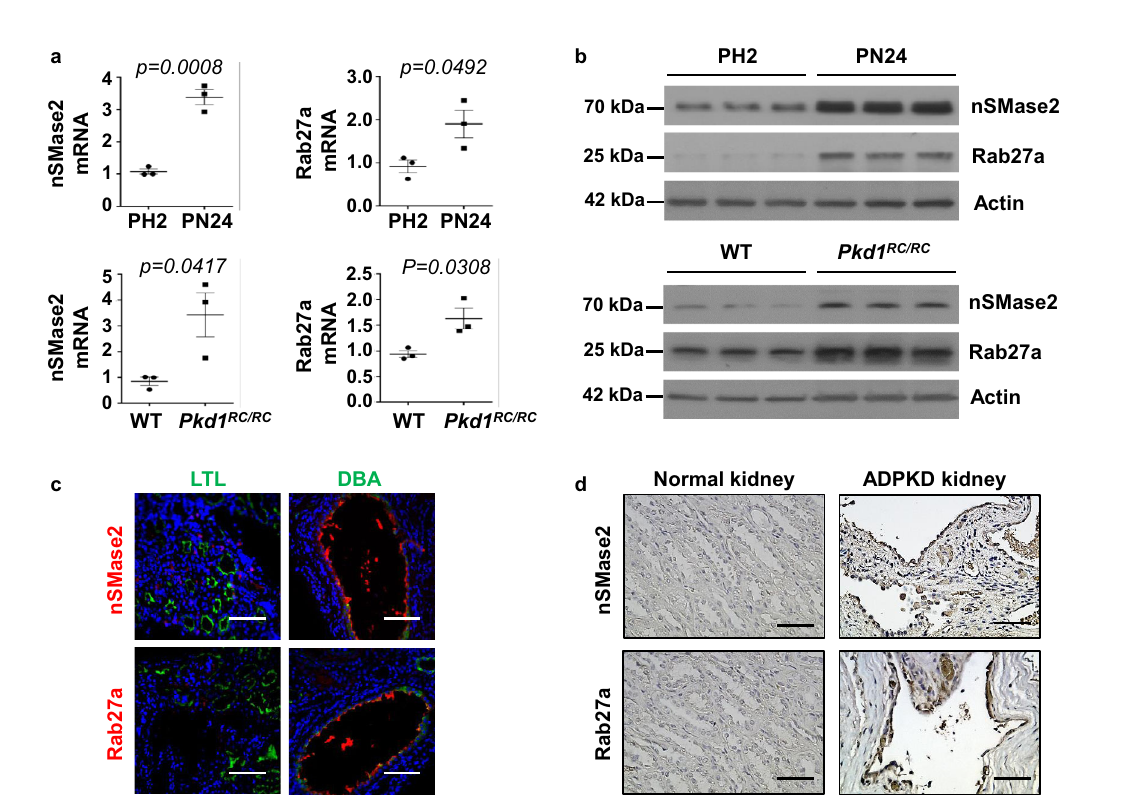
Fig. 7 The expression of exosome biogenesis/release-associated genes was upregulated in Pkd1 mutant renal epithelial cells and tissues. a qRT-PCR analysis of the expression of nSMase2 and Rab27a mRNA in PH2 and PN24 cells (top panel) and in kidneys from WT and Pkd1 RC/RC mice (bottom panel). n = 3 independent experiments. All statistical data are represented as mean ± SEM, and p-values are calculated by unpaired Student ’ s t -test. b Western blot analysis of nSMase2 and Rab27a expression from whole-cell lysates of PH2 cells and PN24 cells (top panel) and in kidneys from WT and Pkd1 RC/RC mice (bottom panel). c Immuno fl uorescence staining indicated that the expression of nSMase2 and Rab27a was increased in cyst lining epithelial cells in kidneys from Pkd1 RC/RC mice, which were costained with DBA (Dilichos bi fl orus agglutinin) but not LTL (Lotus Tetragonolobus lectin). Scale bars, 100 μ m. n = 3 independent experiments. d Immunohistochemistry analysis indicated that nSMase2 and Rab27a expression was increased in cyst-lining epithelial cells in human ADPKD kidneys but not that in normal human kidneys. Scale bars, 50 μ m. n = 3 independent